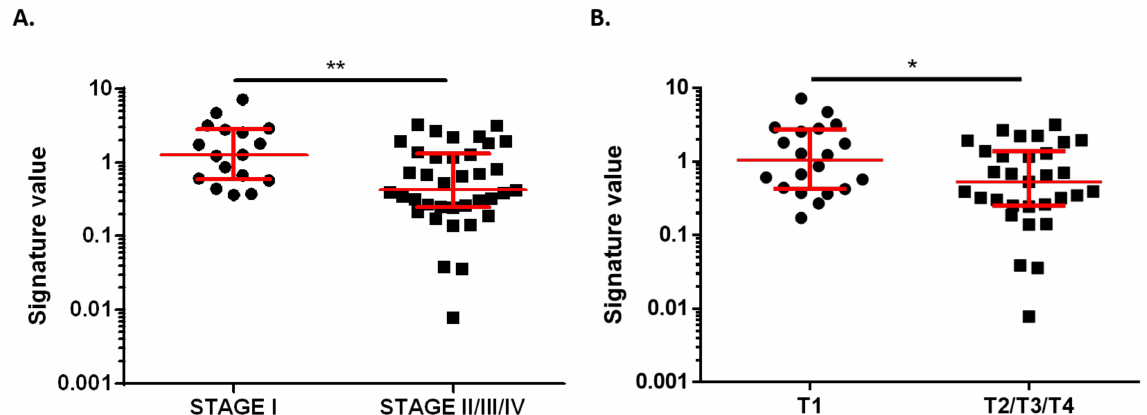
Figure 4. Association between combined signature value and clinicopathological data. ( A ) Signature value in plasma samples from very early-stage BC patients (stage I, n = 17) and in patients with advanced disease (stage II, III, IV, n = 37). ( B ) Signature value in plasma samples from BC patients with tumor size ≤ 20 mm (T1, n = 20) and in patients with tumor size >20 mm (T2, T3, T4, n = 31). Red lines represent median ± interquartile range. * p < 0.05; ** p < 0.01.